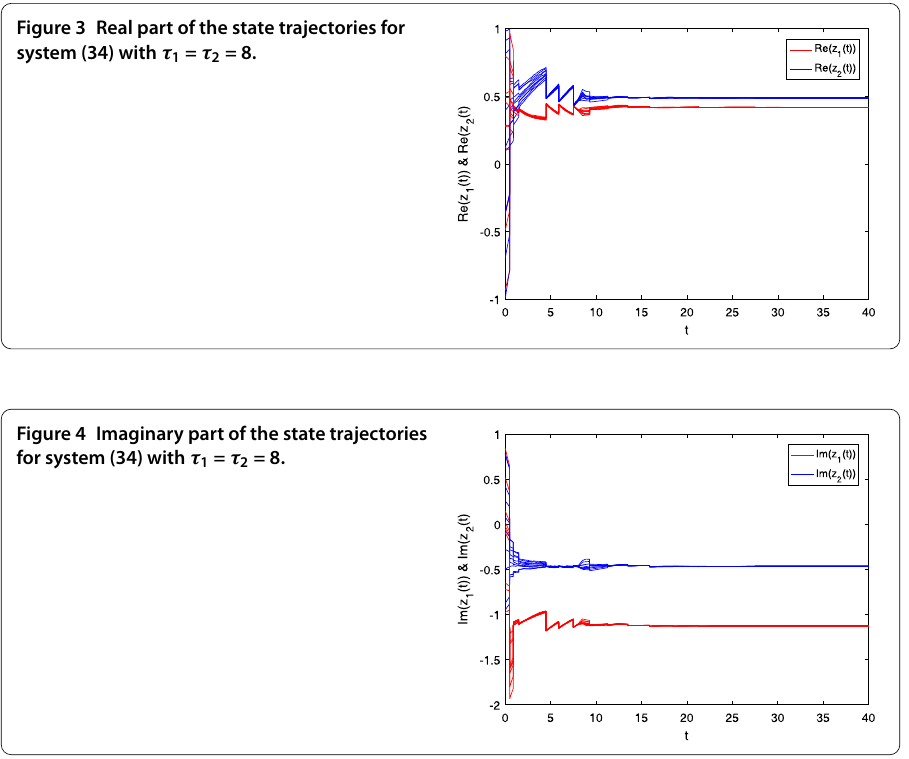
Figure 4 Imaginary part of the state trajectories for system (34) with τ 1 = τ 2 =